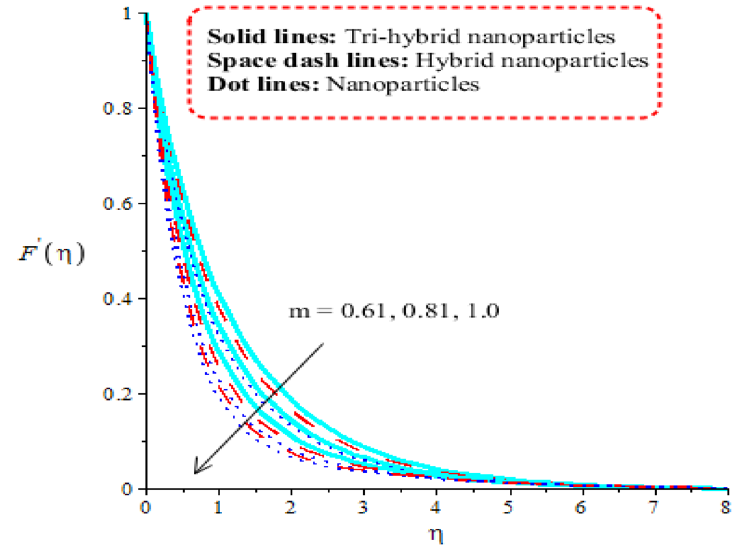
Figure 5. Distribution in F ′ (η) against m .